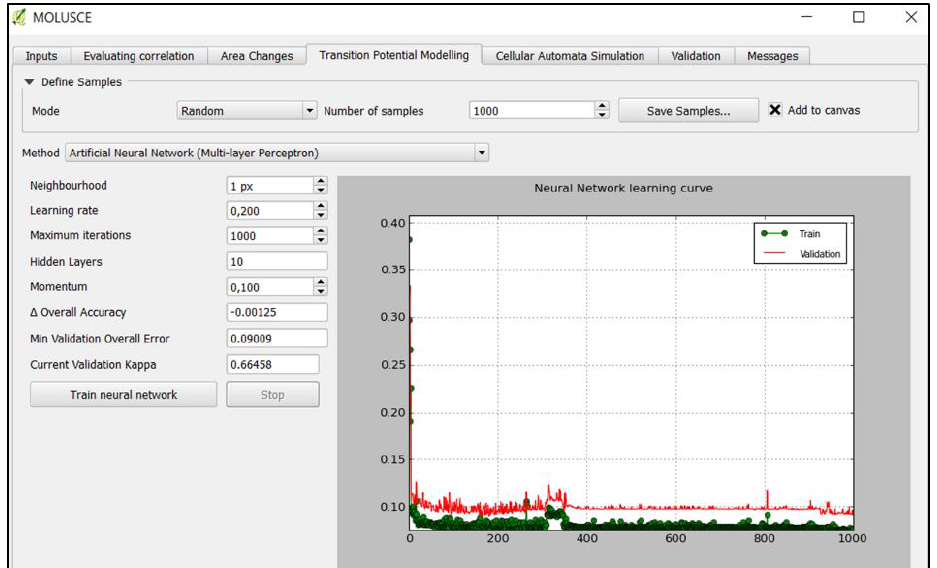
Figure 13. Transitional potential modeling (MOLUSCE) .